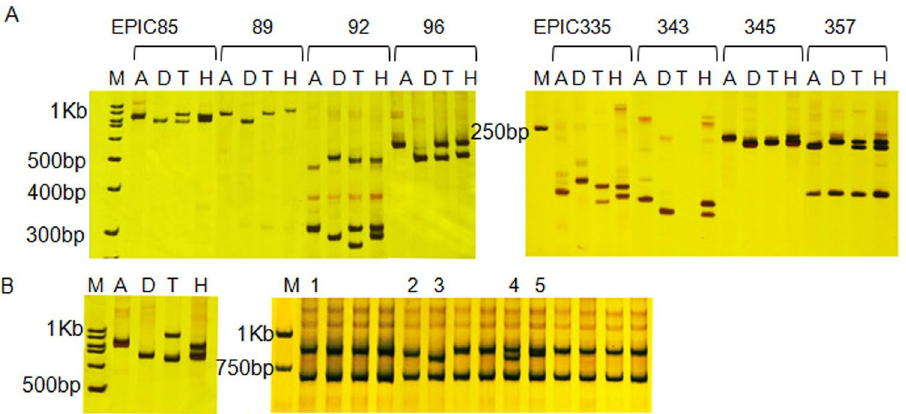
Figure 2. Electropherogram of detecting ILP markers polymorphism in cotton. ( A ) Electropherogram of ILP marker in four cotton species. M: marker; A: G . herbaceum var. africanum ; D: G . raimondii ; T: G . hirsutum acc. TM-1; H: G . barbadense cv. Hai7124. ( B ) Electropherogram of ILP marker EPIC211 in different G . hirsutum accessions. M: marker; A: G . herbaceum var. africanum ; D: G . raimondii ; T: G . hirsutum acc. TM-1; H: G . barbadense cv. Hai7124. Numbers 1–5 represents five alleles for EPIC211 detected in different G . hirsutum